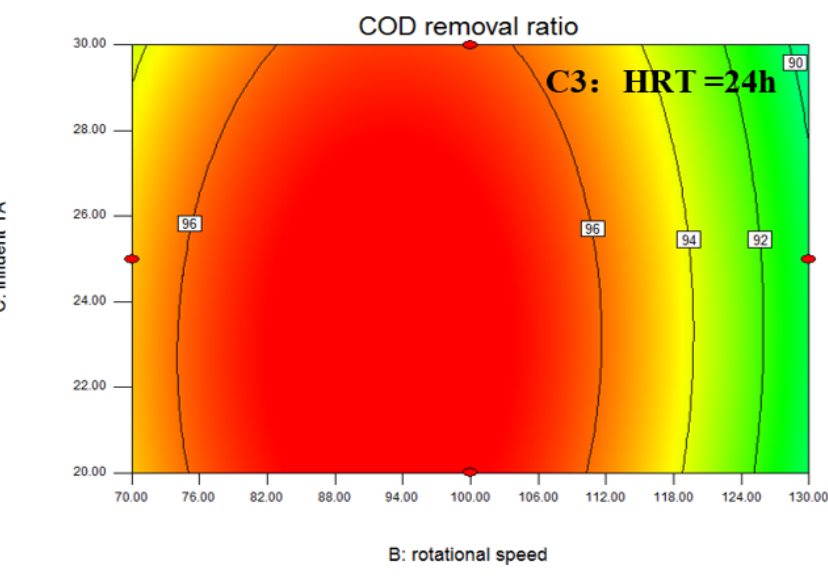
Figure 2. Response contour plots for the effect of ( A1 – A3 ) HRT and rotational speed, ( B1 – B3 ) HRT and influent TA, ( C1 – C3 ) rotational speed and influent TA on COD removal